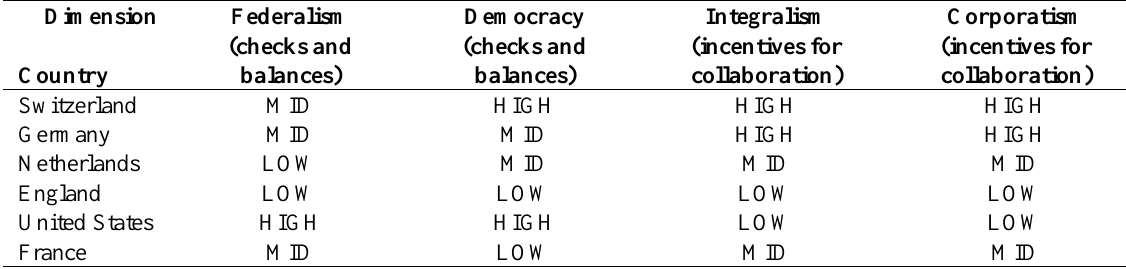
Table 1. Country scores in the four institutional dimensions Dimension Federalism (checks and Country balances) balances) collaboration)